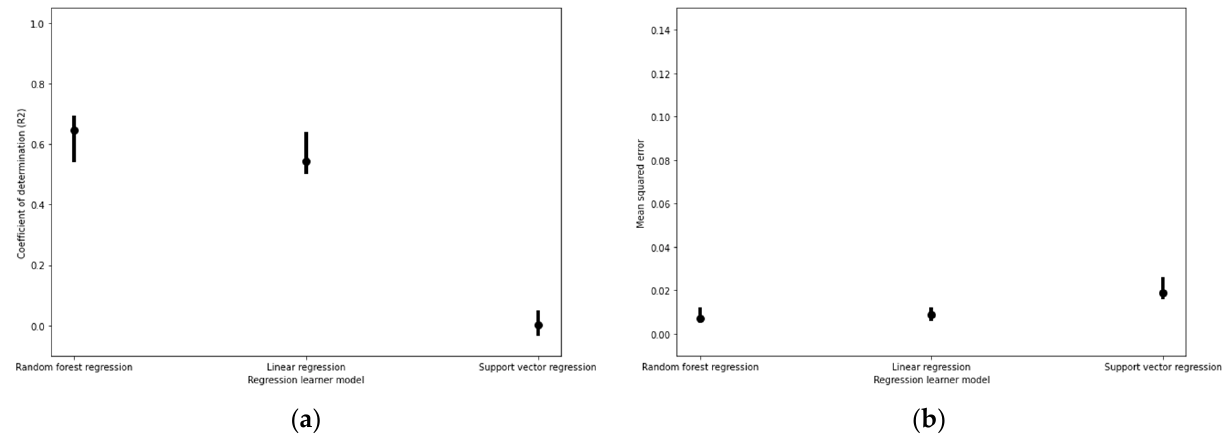
Figure 4. Filament diameter regression model performance based on ( a ) coefficients of determination (R 2 ) and ( b ) mean squared error (MSE) values under fivefold cross validation. The upper and lower bounds of the error plots represent the maximum and minimum R 2 and MSE values produced amongst all five combinations of one fold being trained and tested on the remaining four folds.